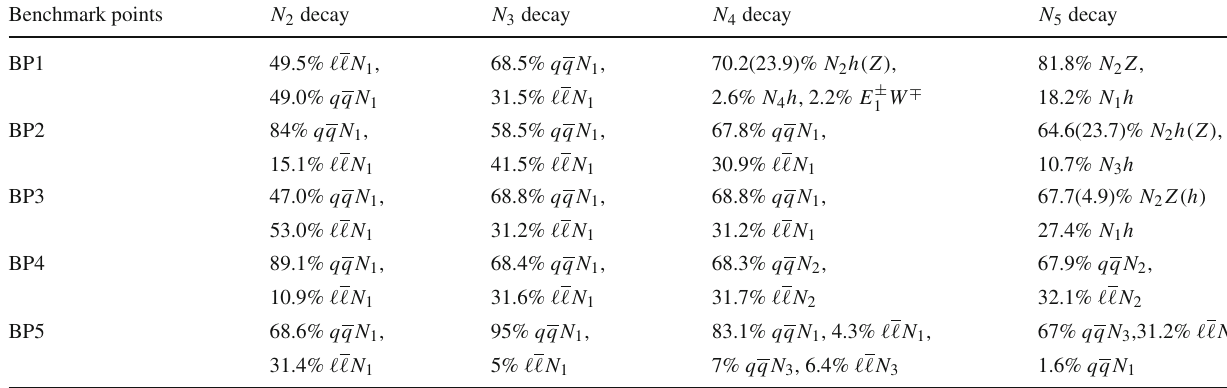
Table 19 Decay modes for neutral